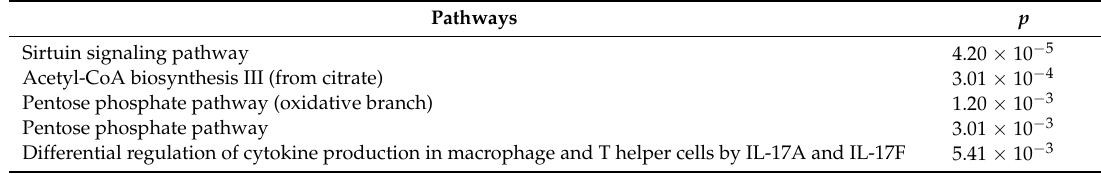
Table 7. List of top five most significant canonical